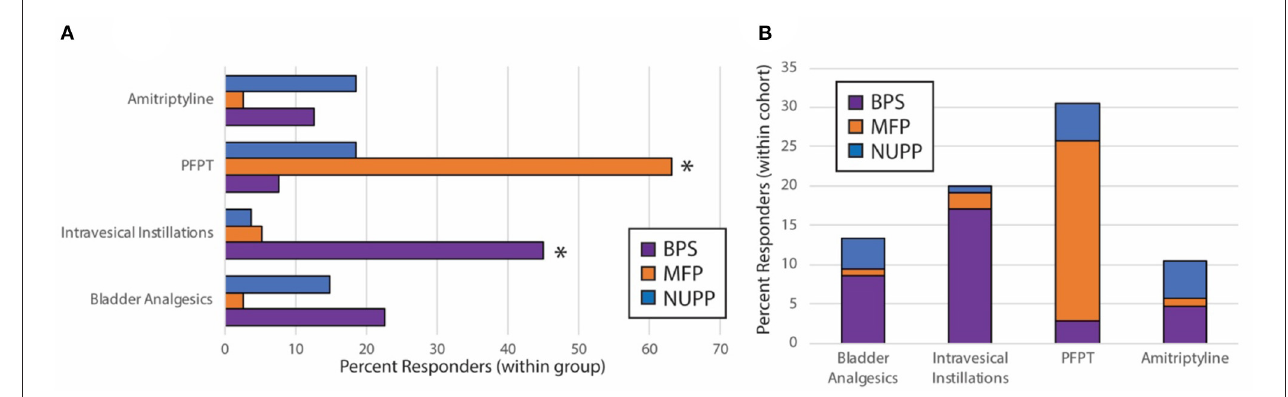
FIGURE 7 | Subjective treatment responses vary by phenotype. Chart review of subjects in the BPS, MFP, and NUPP groups was used to assess binary responsivity (responded yes/no) to several typical therapies prescribed for IC/BPS patients. (A) Responder rates for patients were expressed as a percentage of each individual phenotype. The starred treatment groups were statistically different from both of the other groups (* p < 0.001 for pairwise comparisons with both other phenotypes). (B) The proportion of responders within the total population was expressed for each therapy, demonstrating that the majority of responders to the bladder-directed therapies (bladder analgesics and intravesical instillations) were BPS patients, while the majority of responders to PFPT were MFP subjects. Responses were only assessed for those subjects who attempted the designated